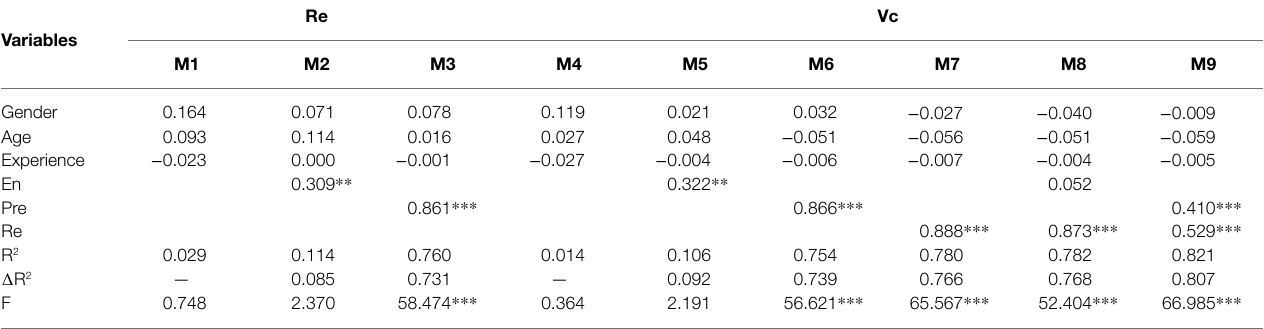
TABLE 5 | Mediation effect test of relational capital.